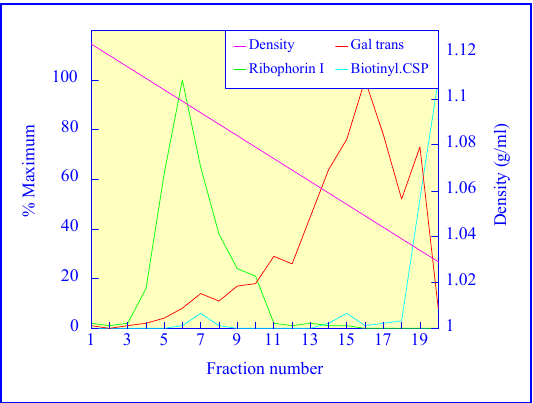
FIGURE 1 . Distribution of Golgi, ER, and plasma membrane markers from CHO cells in a 0 – 26% iodixanol gradient (115 min at 200,000 g av . Gal trans = galactosyl transferase; Biotinyl.CSP = biotinylated cell surface proteins. Figure adapted from Ref. 1 with kind permission of the American Society for Biochemistry and Molecular Biology and the